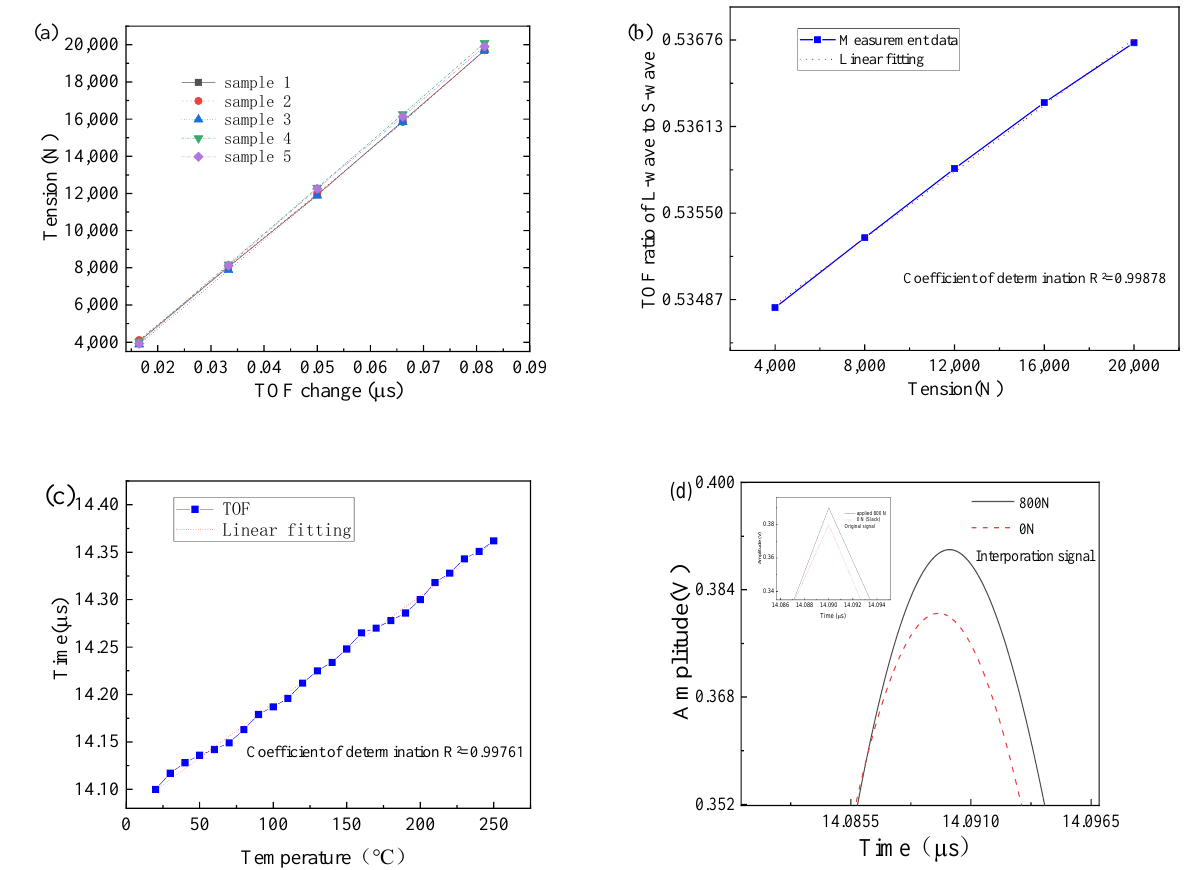
Figure 7. ( a ) Relationship between the TOF difference and the tension; ( b ) TOF ratio of the first longitudinal wave to the first shear wave as a function of the tension; ( c ) relationship between the temperature and TOF in an unstressed bolt; ( d ) TOF change before and after the applied axial preload of 800 N after interpolation. The inset is the original temporal signal of the first longitudinal wave for the cases of 0 N and 800 N.